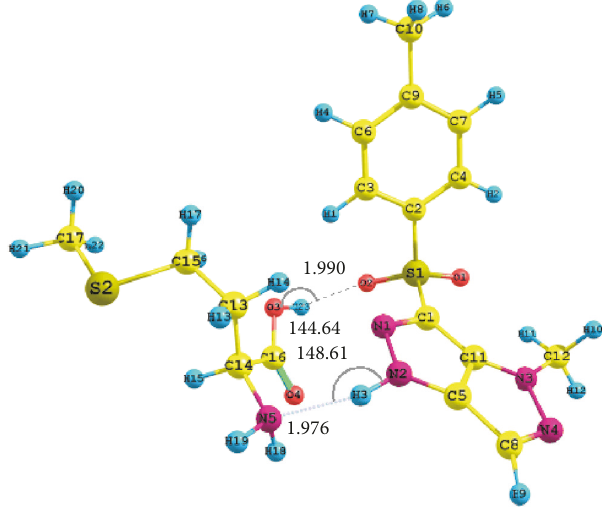
Figure 4: The optimized 7 –methionine adduct 7Met B (B3LYP/6- 31G(d,p)).